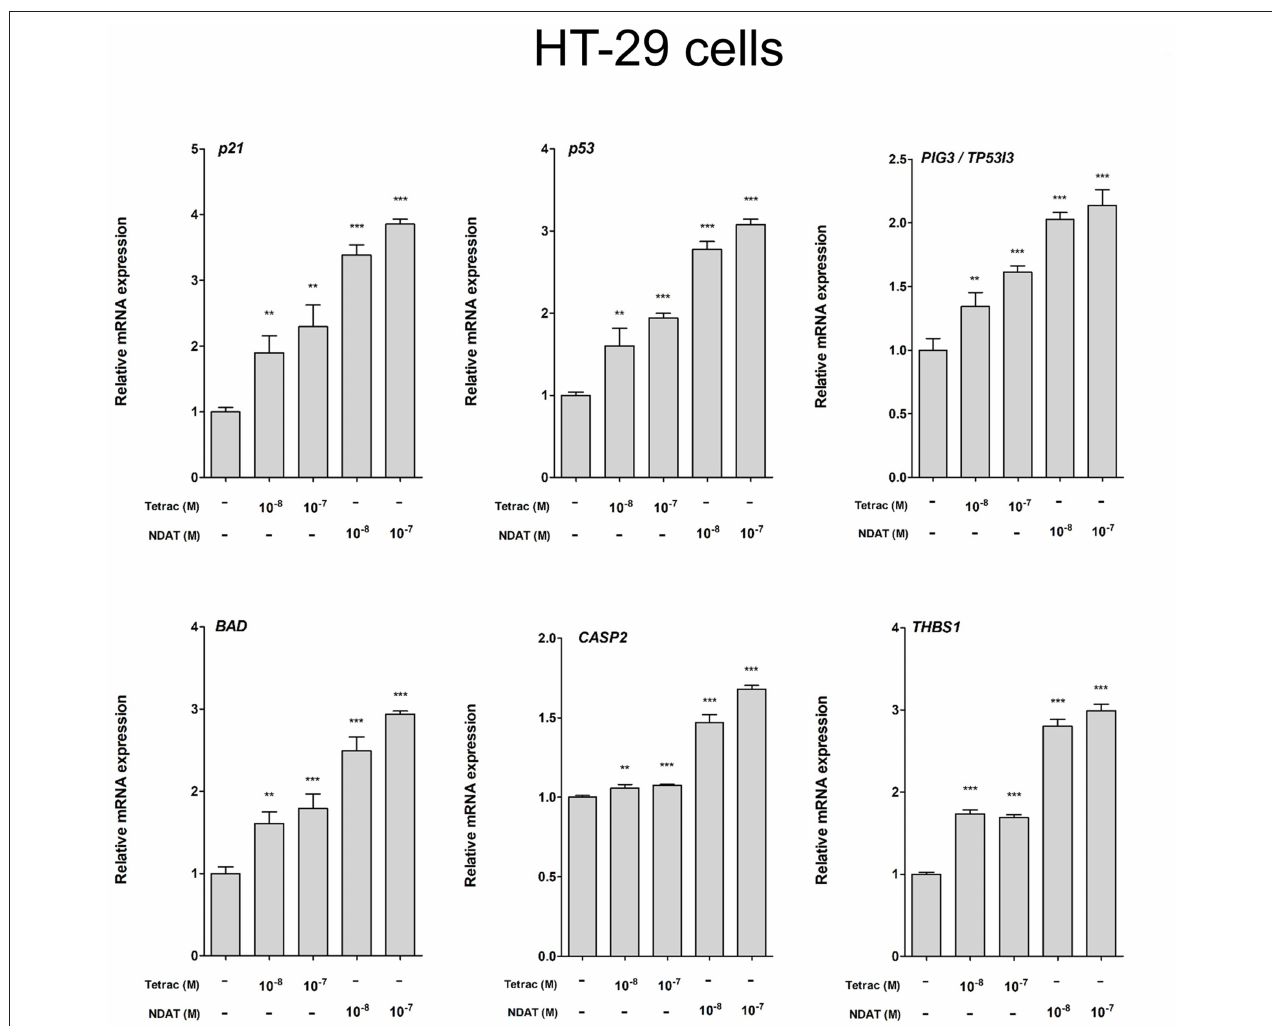
FIGURE 5 | Tetrac and NDAT suppress expression of proliferative and metastasis-related genes in HT-29 cancer cells. HT-29 cells were seeded in 6-well plates and treated with different concentrations of 10 − 8 and 10 − 7 M tetrac or NDAT for 24h. Cells were harvested and total RNA was extracted. qPCR experiments were conducted to examine expression of anti-proliferative genes ( p21, p53, and PIG3 ), apoptotic genes ( BAD and CASP2 ) and metastasis-related genes ( THBS1 ). N = 6. (Data are expressed as mean. ± SD; * p < 0.05, ** p < 0.01, *** p < 0.001, compared with untreated